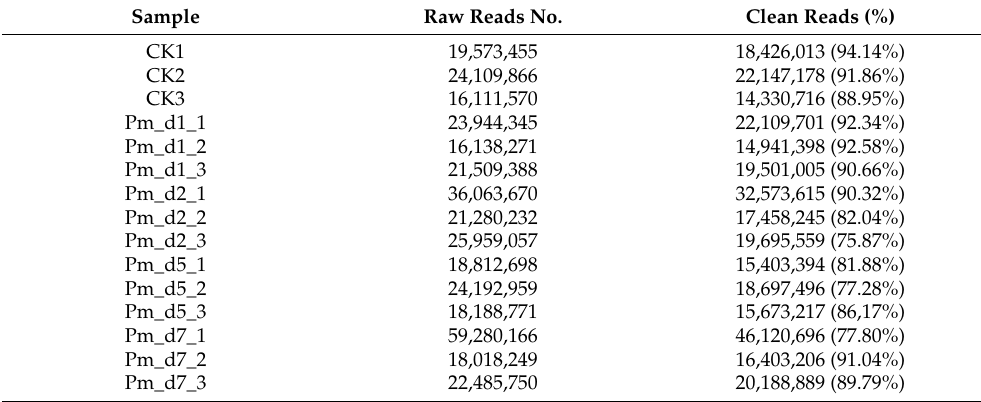
Table A2. Characterization of sequencing data for small RNAs from the lungs of the goats in each